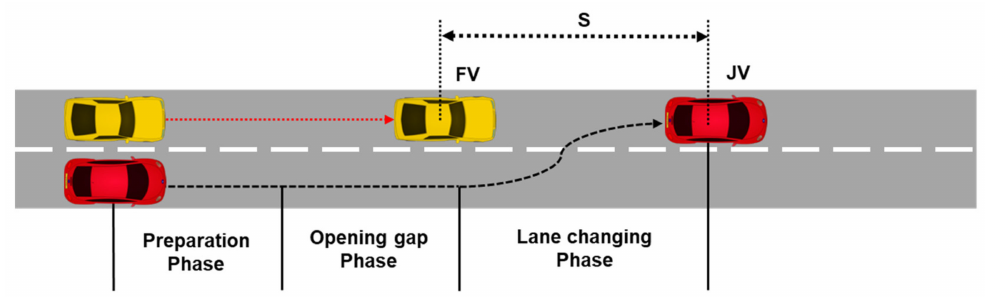
Figure 5. Construction of the expected